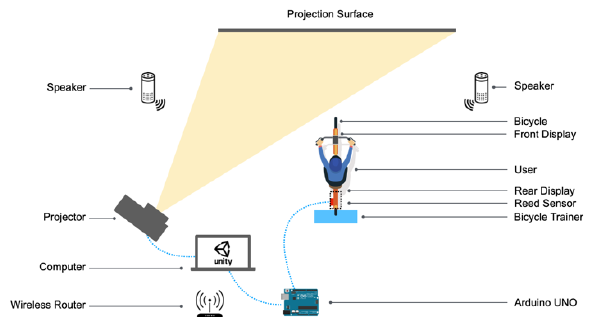
Figure. 3. Schematic of the Cycling Simulation System (Top View).